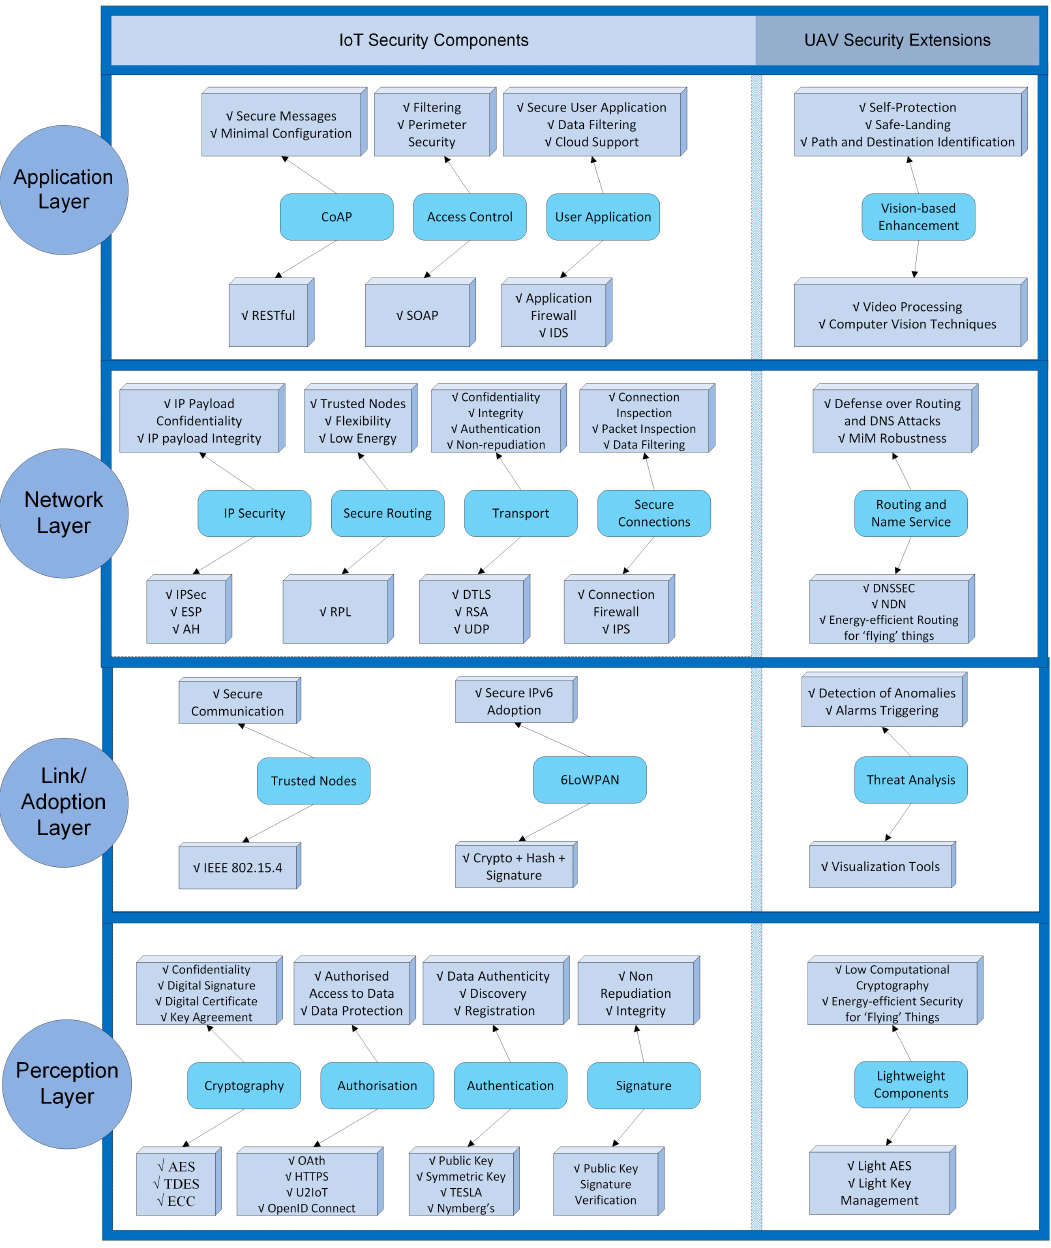
Figure 2. IoT security layers with UAV